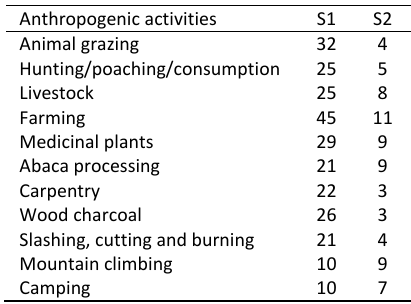
Table 5: Anthropogenic activities recorded in S1 and S2, Mt. Manunggal, Cebu Island,